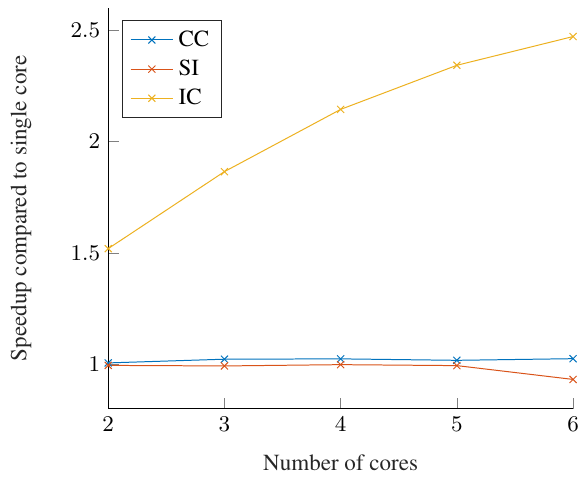
Figure 5: Average speedup as a function of the number of cores. Only the IC algorithm benefits from an increased number of cores, but at a diminishing rate as the number of available cores increases. Compared to the legacy algorithm in DBAT, the IC algorithm was 1-2 orders of magnitude